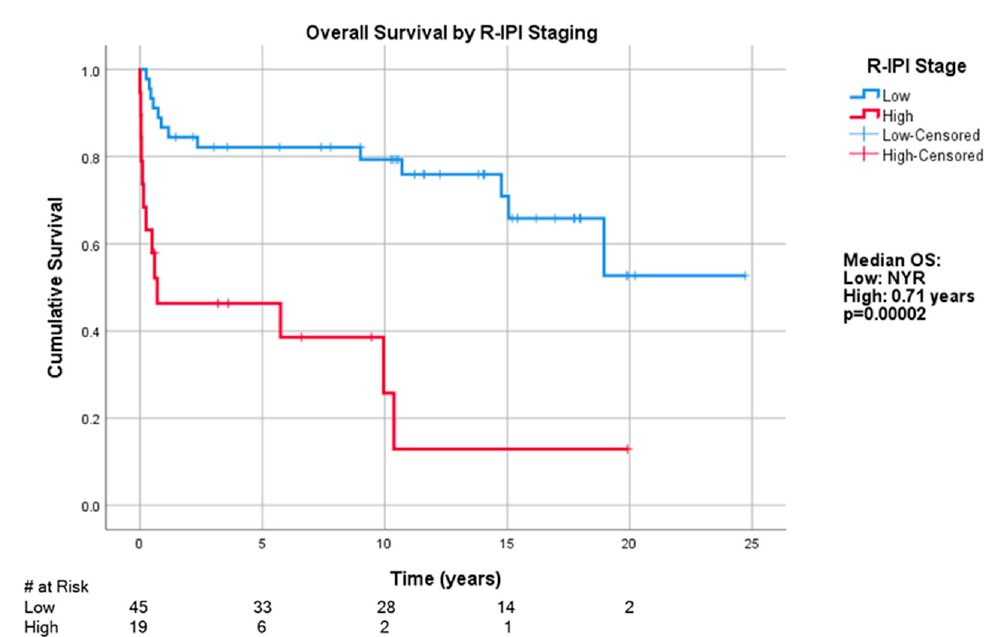
Figure 2. ( A ). Overall survival in this study population. ( B ). Overall survival categorized by Revised International Prognostic Index (R-IPI) staging.